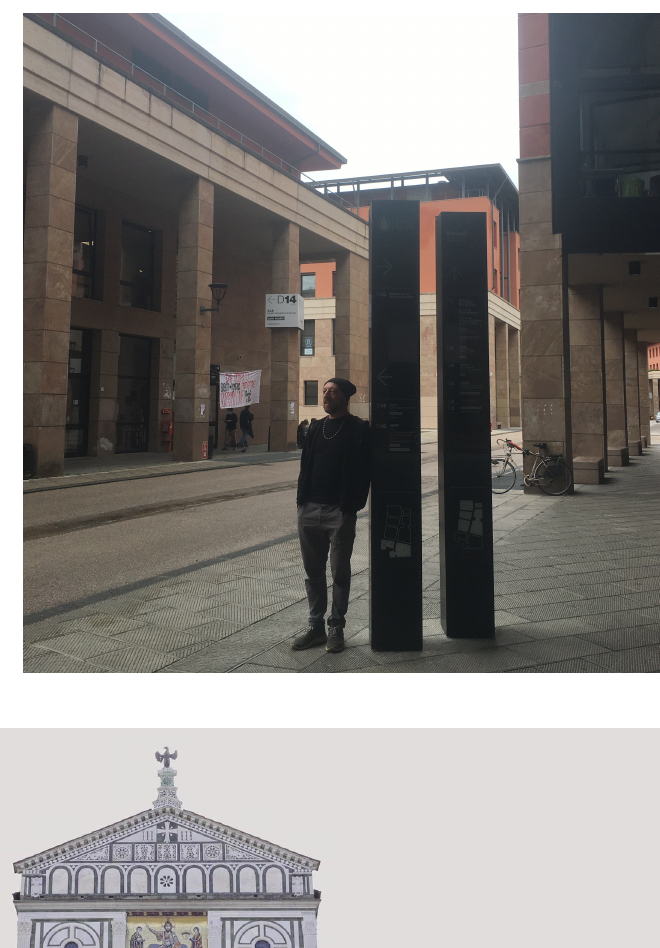
Fig. 5 F. Pinzani sings Seeds of Beauty , “I am looking for love and unity, I look for beauty in diversity, I look for food